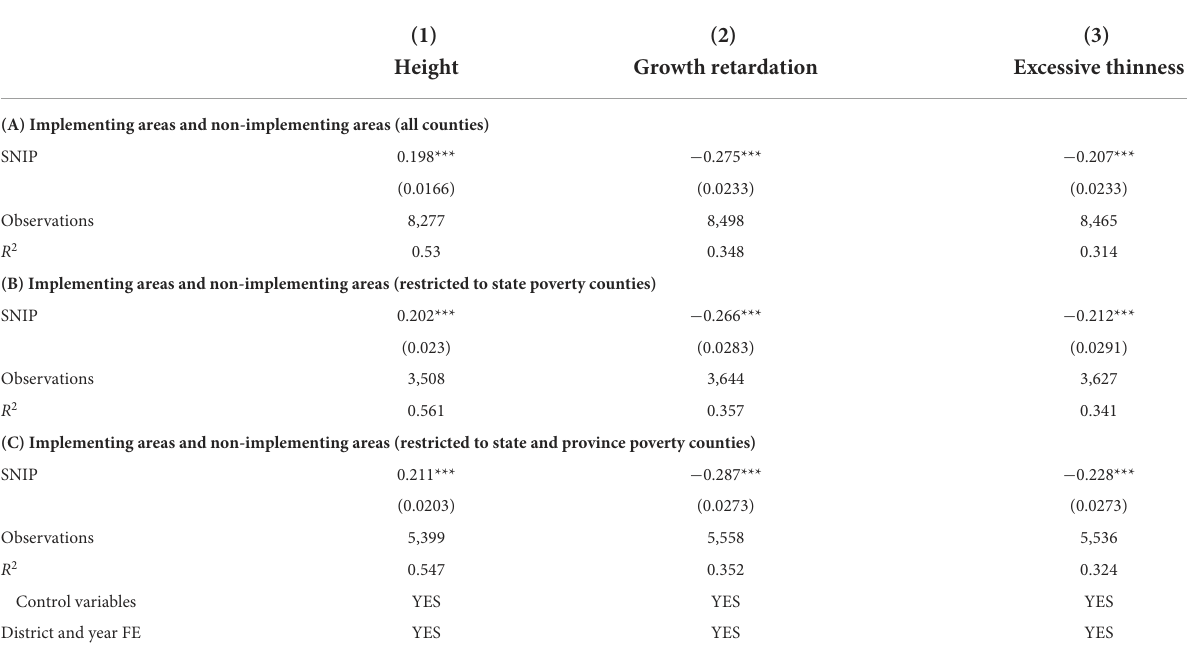
TABLE 7 Physical